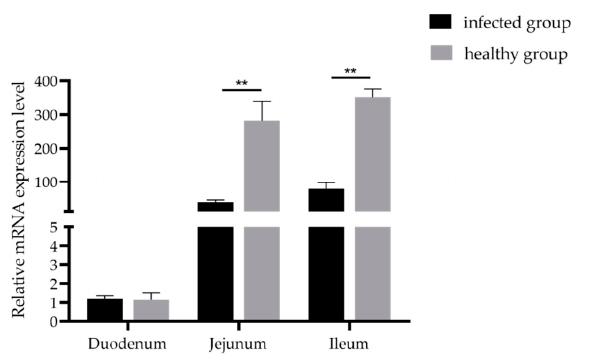
Figure 2. Expression levels of the GLP-2 gene in the PEDV-infected group and healthy group. ** p < 0.01. Bars represent the mean ± SD ( n = 3). ** p < 0.01. Bars represent the mean ± SD ( n = 3).